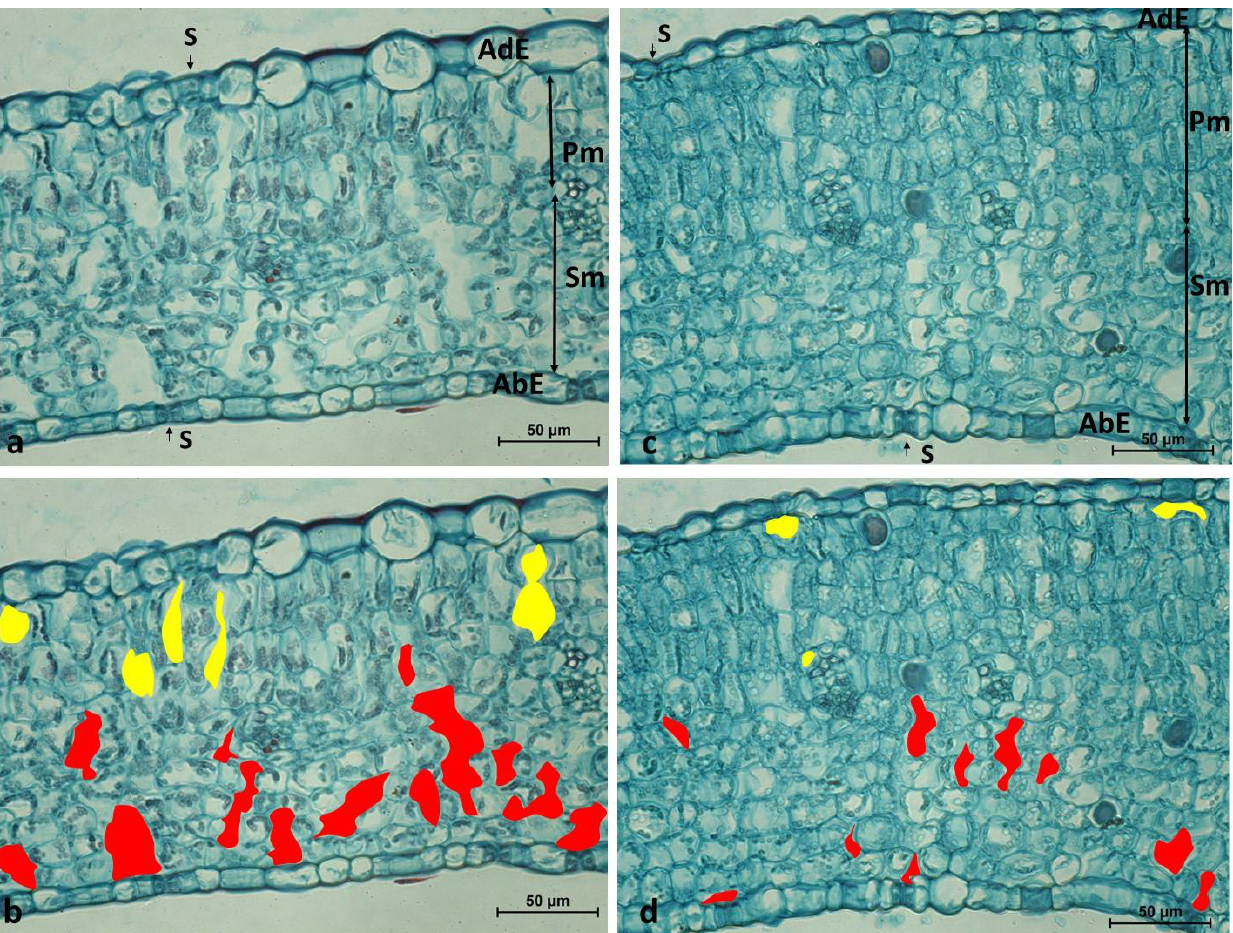
Figure 6. Cross-section of kale leaves stained with safranin-fast green and imaged with light microscopy. ( a , b ) cultivar “Redbor”—susceptible to the cabbage whitefly, ( c , d ) cultivar “Starbor”—resistant to the cabbage whitefly. ( b , d ) visualization of intercellular spaces in palisade mesophyll (yellow) and spongy mesophyll (red). Cultivars Abbreviations: AdE—adaxial epidermis, AbE—abaxial epidermis, Pm—palisade mesophyll, Sm—spongy mesophyll, S—stomata.